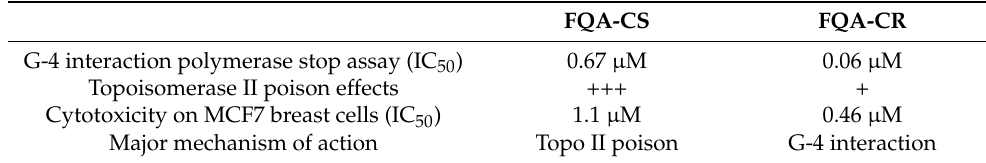
Table 1. Summary of the biological activities of FQA-CS and FQA-CR.